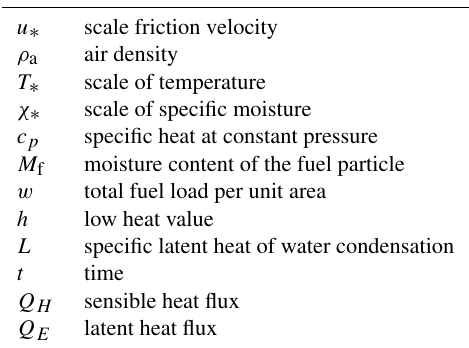
Table 4. List of symbols in the SFIRE